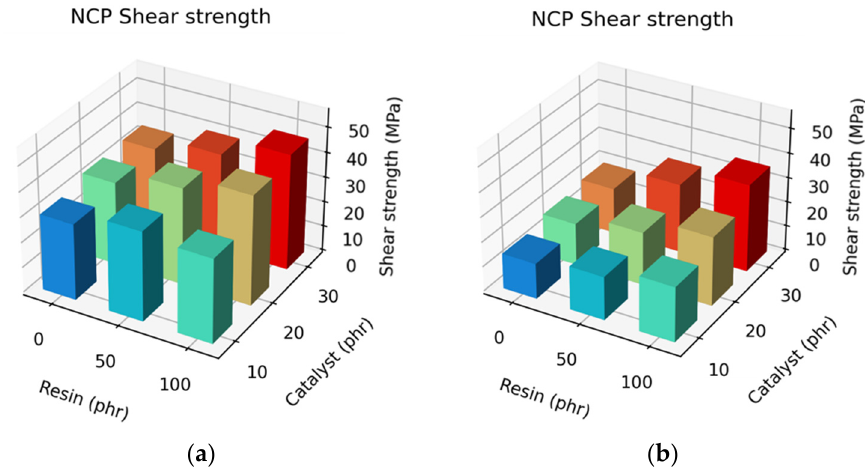
Figure 7. The predicted shear strength with DGEBA (resin) and HX-3941 (catalyst) ( a ) with hardener and ( b ) without hardener. and ( b ) without hardener.